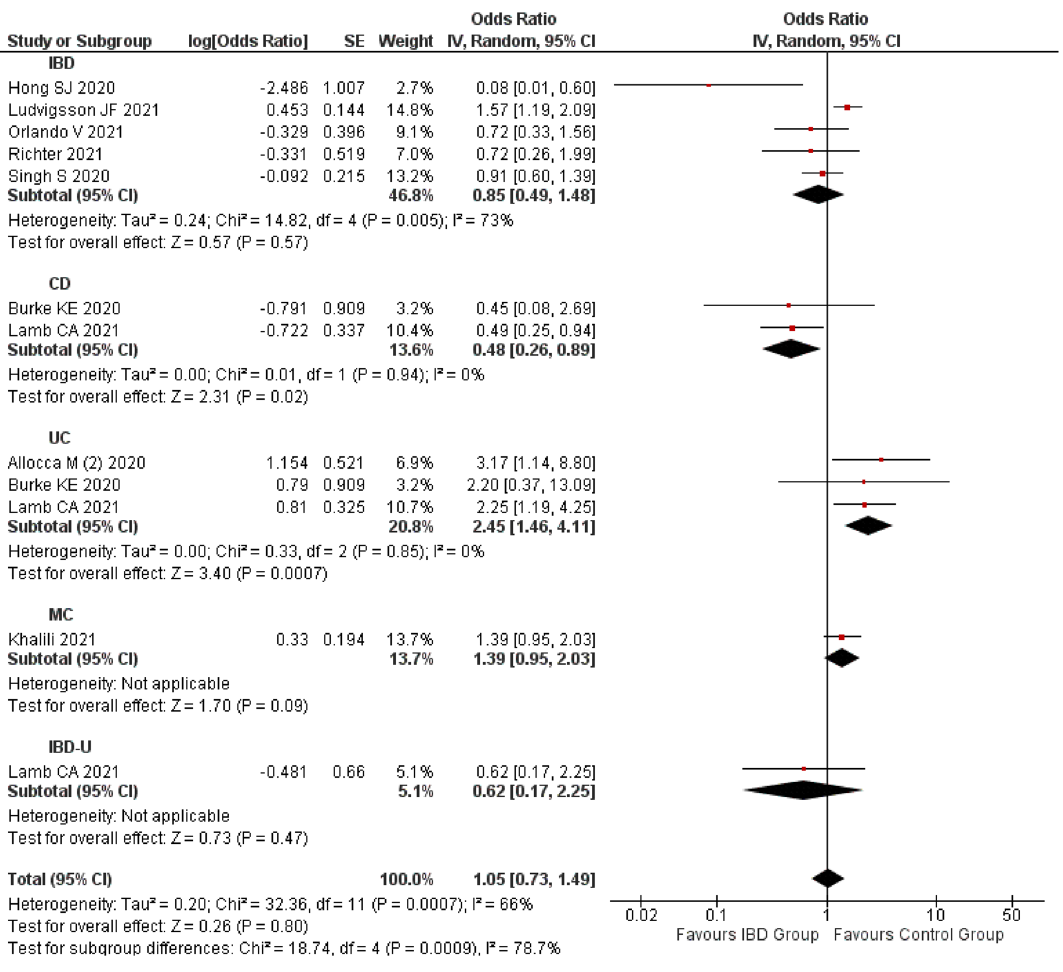
Figure 7. Risk of severe COVID-19 among the patients with